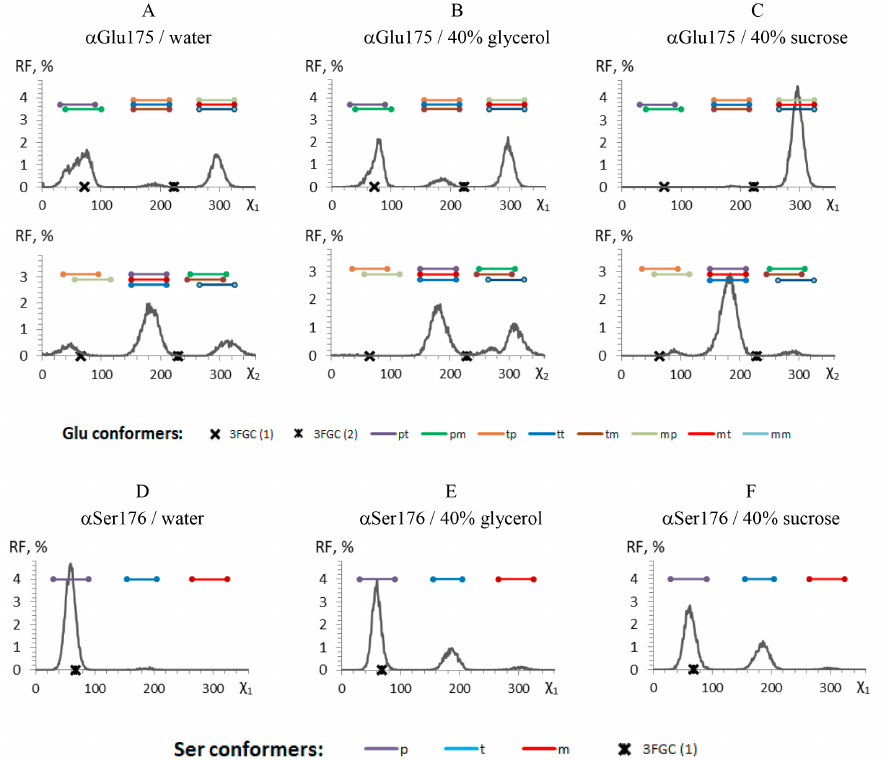
Figure 8. The relative frequency (RF) of side-chain conformations of the selected residuals during the molecular dynamic simulation in water and high concentration of the cosolvents: ( A – C )— χ 1 (the upper panel) and χ 2 (the lower panel) dihedrals of α Glu175; ( D – F )— χ 1 dihedral of α Ser176. The colored straight lines indicate the dihedral intervals of the known conformations (according to [39]). The crosses indicate the conformers found in the luciferase crystal (PDB ID: 3FGC)